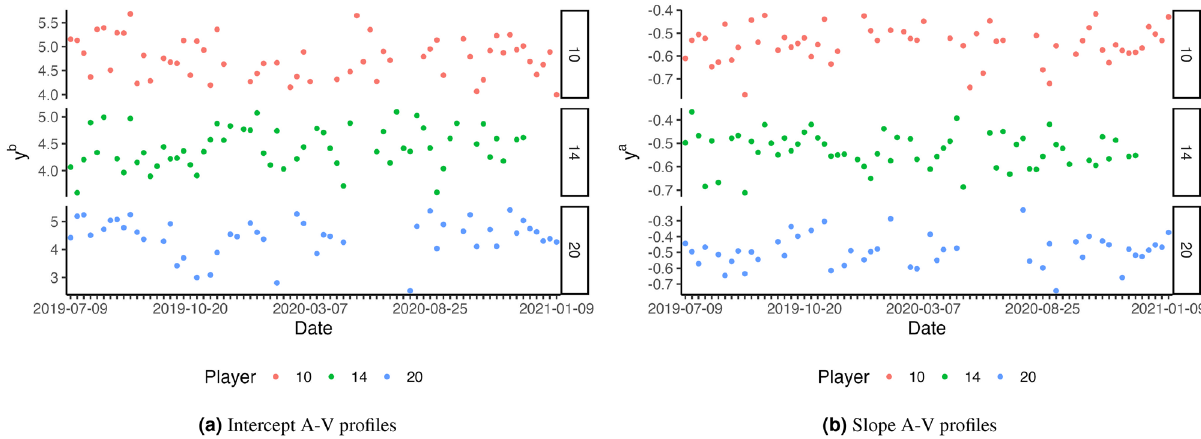
Figure 2. Evolution of A-V profiles fitted intercept and slopes over the 1.5 season period. Three players are randomly